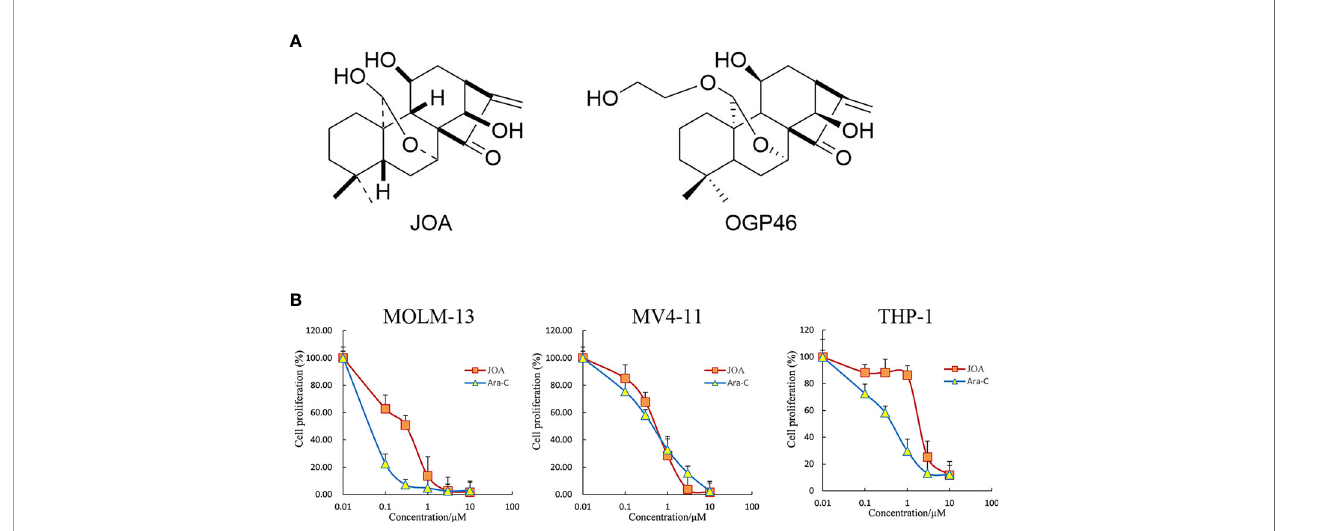
FIGURE 1 | JOA reduces the proliferation of MV4-11, MOLM-13 and THP-1 cells. (A) The chemical structure of JOA and OGP46. (B) The effect of JOA in inhibiting cellular proliferation. Cells were treated with different concentrations of JOA or Ara-C (0- 10 m M) for 72 h, and subjected to CCK-8 assay. Error bars represent the mean ± SD. The CCK-8 assay was carried out for four times in